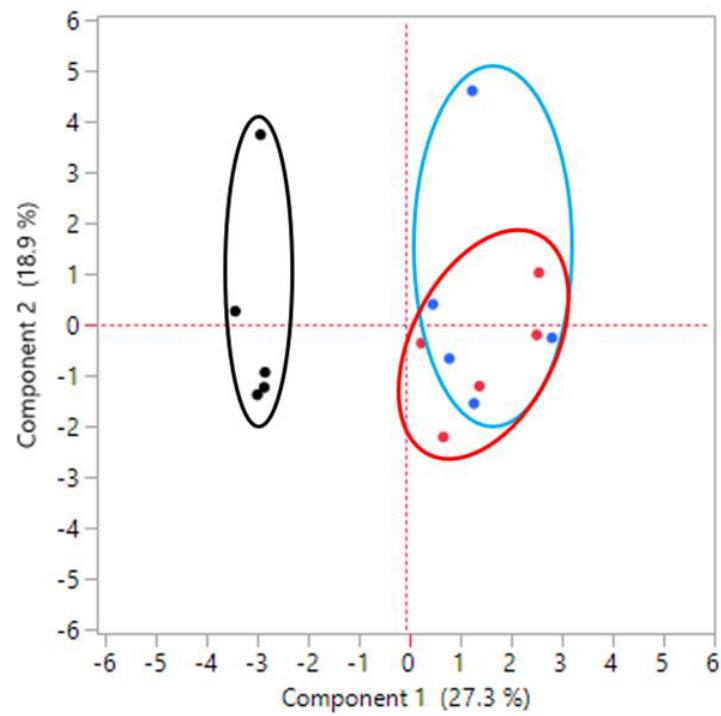
Figure 6. Principal component analysis showing the difference in the small intestinal microbiota composition between groups. Black dot: normal group, without treatment. Blue dot: control group, with antibiotic-associated diarrhea (AAD). Red dot: sample group, Lizhong-tang -administered group, post-AAD establishment.